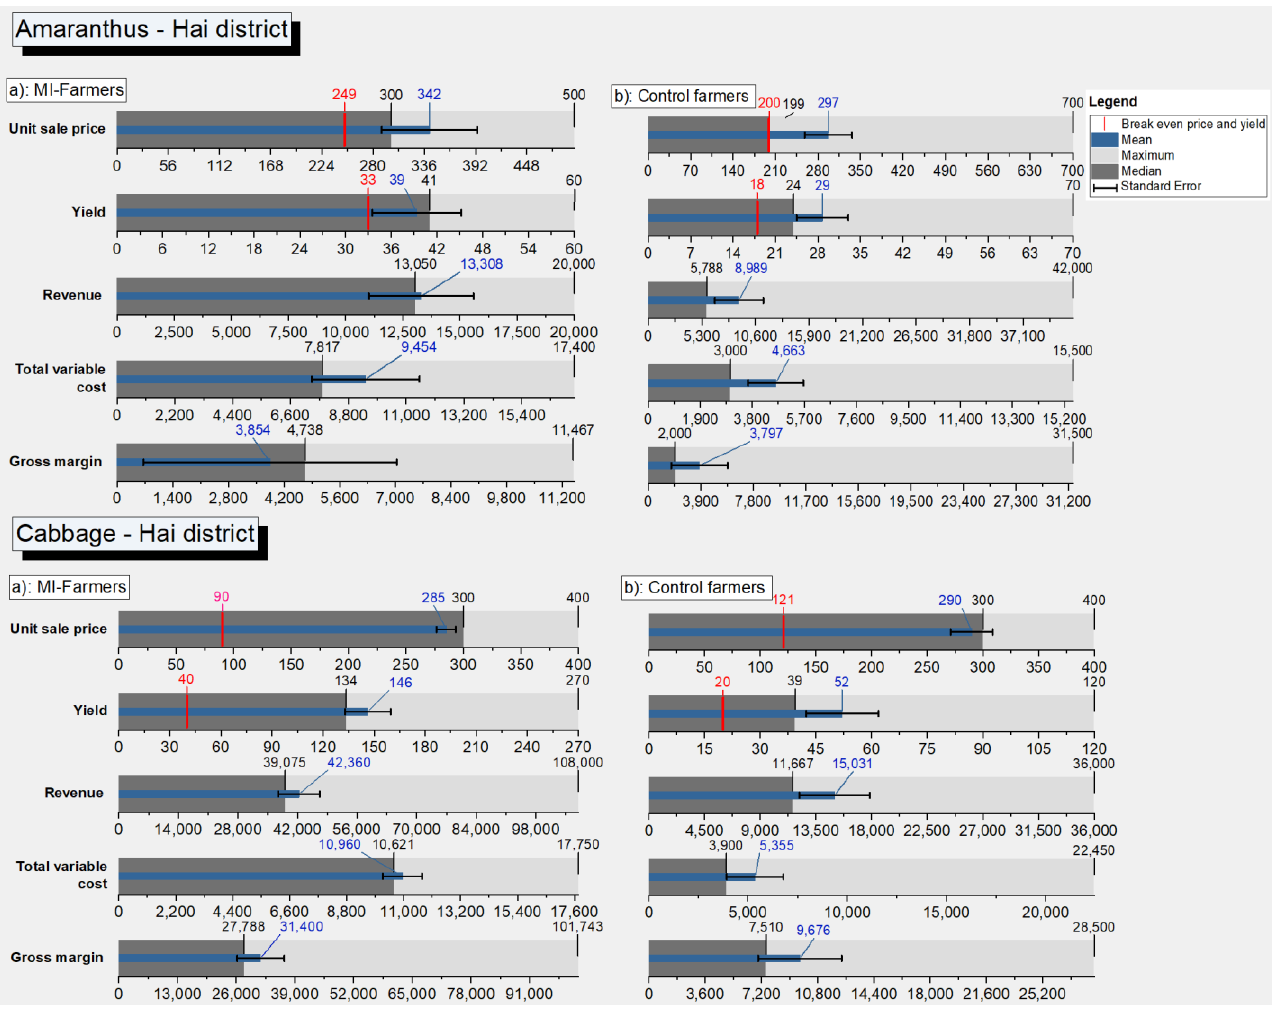
Figure 3. Enterprise comparison of MI farmers ( a ) and control farmers ( b ) growing Amaranthus and cabbage in the Hai district. Price, revenue, total variable cost (TVC), and gross margin (GM) amounts are presented in Tanzanian Shilling (TSh), where 1 USD = 2330 TSh and 1 TSh = 0.00043 USD. Yield is calculated as per bed per season. Standard error of mean is presented as error bars for each bar graph.